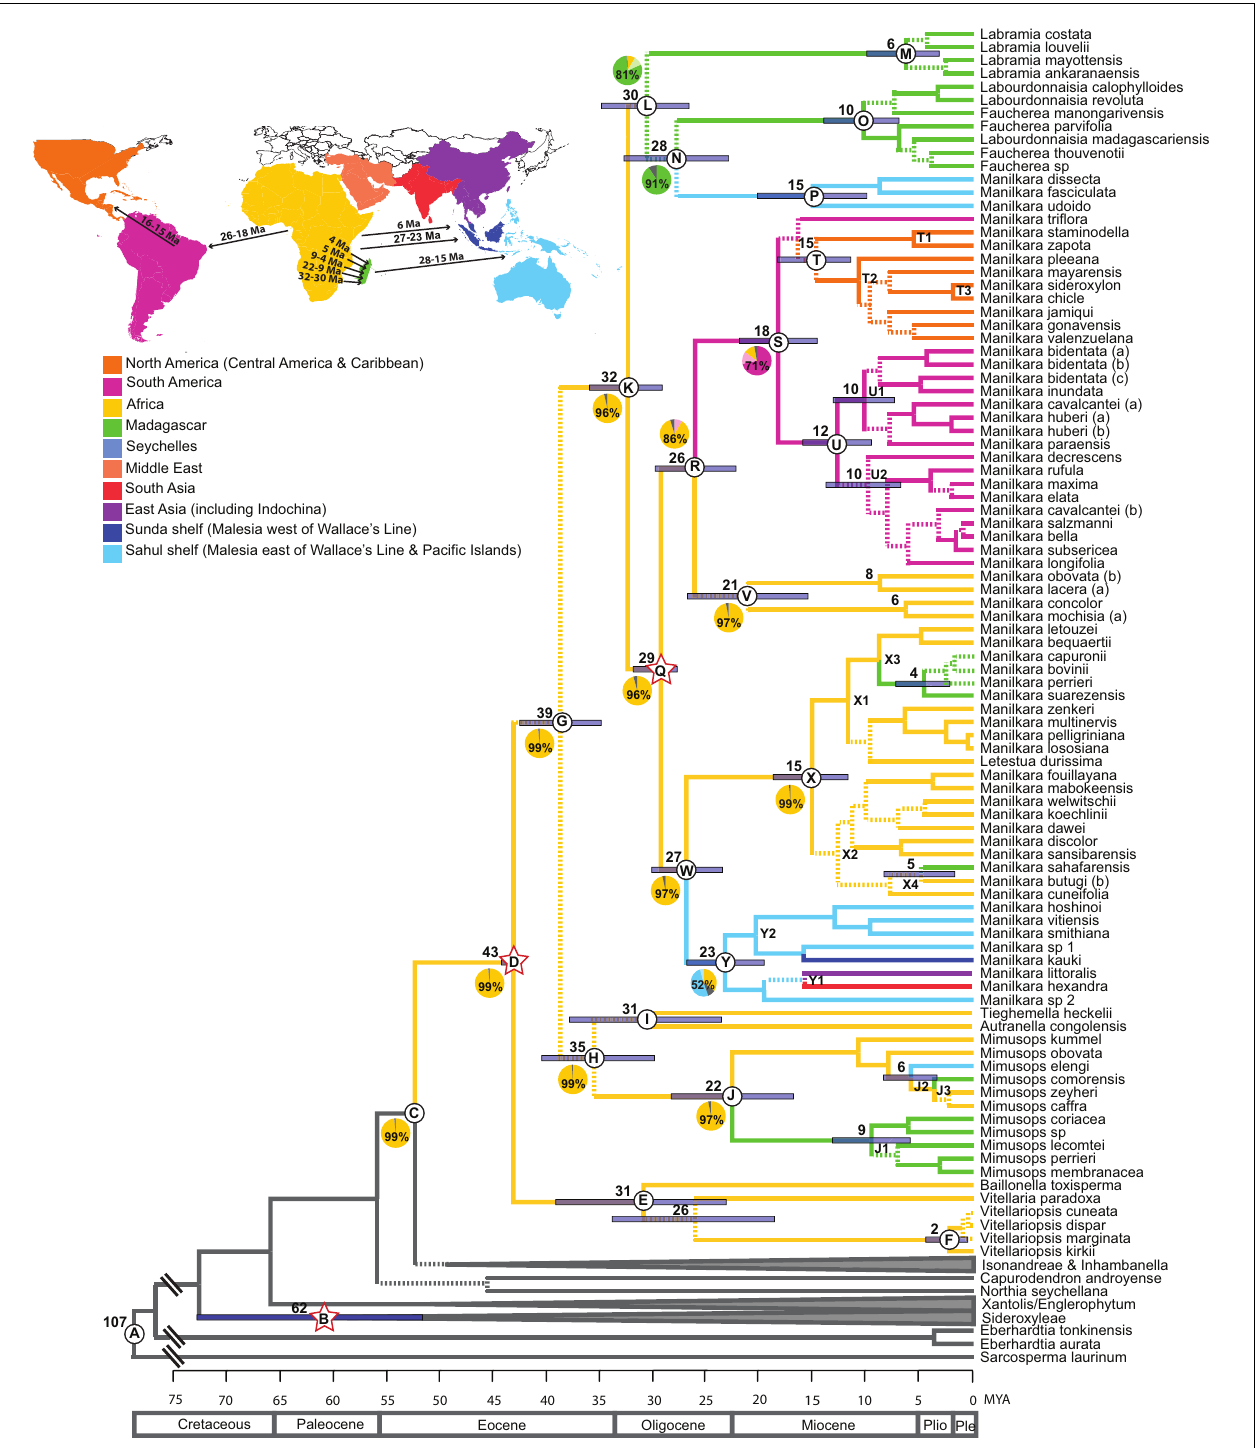
FIGURE 1 | Maximum clade credibility chronogram of the ITS dataset. Dashed lines indicate branches which lead to nodes with a posterior probability of < 0.95. Mean ages are given for profiled nodes. Node bars indicate 95% HPD age ranges. Lettered nodes are discussed in the text. Stars indicate the placement of fossils. Lineages are colored according to their distribution: Yellow, Africa; Green, Madagascar; Blue, Asia; Pink, South America; Orange, Central America and the Caribbean. Geological